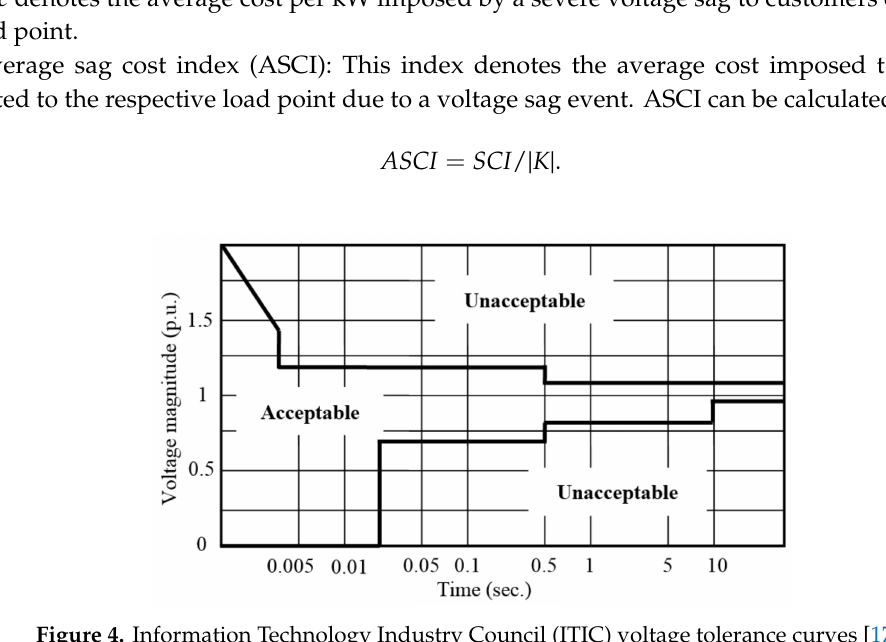
Figure 4. Information Technology Industry Council (ITIC) voltage tolerance curves